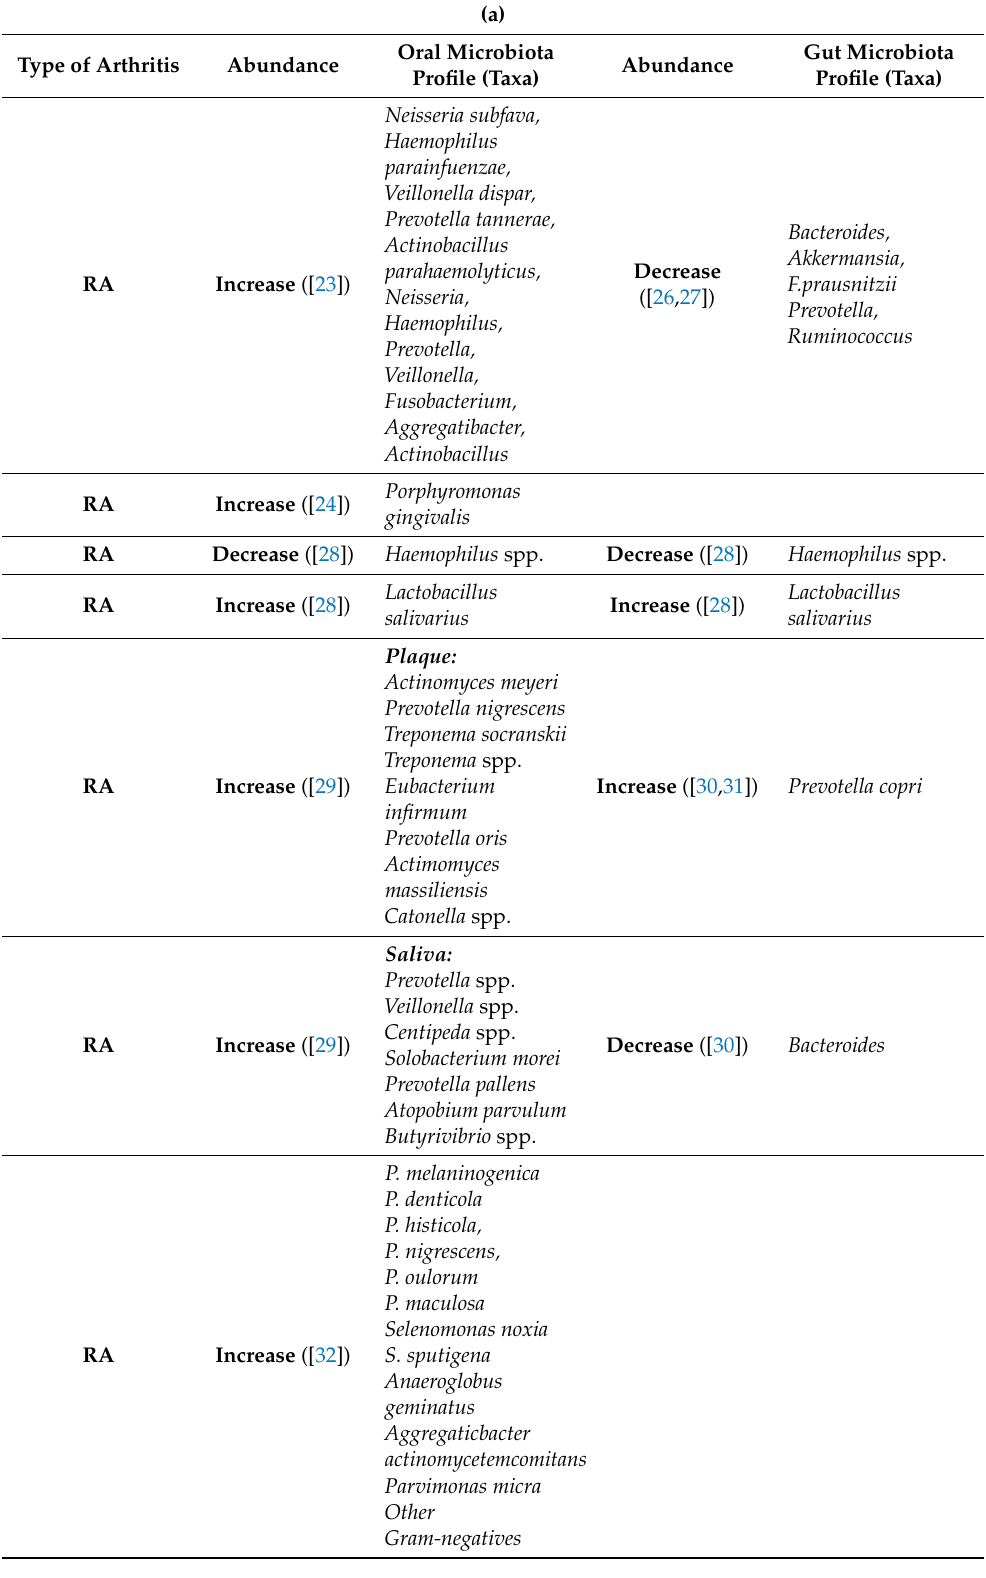
Table 1. Di ff erences of bacterial abundance (taxa) in oral and gut microbiota of rheumatoid